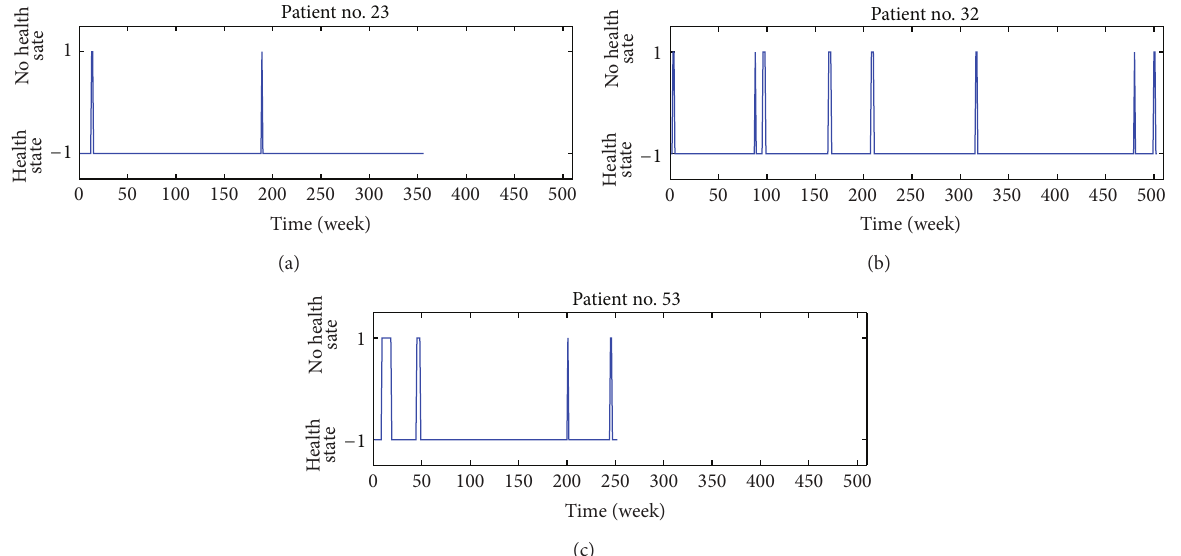
Figure 2: Time evolution of health and no health states for three sample patients taken from the set of 70 patients. The health state of each patient has been represented by a sequence of plus one (+1) and minus one ( − 1) corresponding to the states of relapses and remissions, respectively. Events are reported on a weekly scale and the shift to a secondary progressive form of the disease has been excluded.